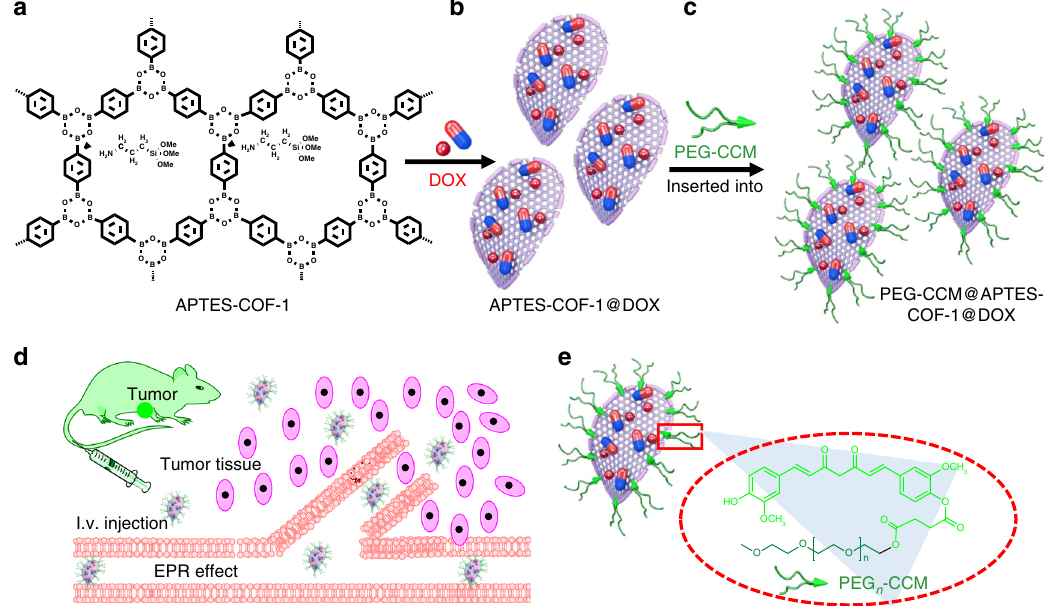
Fig. 1 Schematic representations. a – d Synthesis of DOX-loaded PEG-CCM@APTES-COF-1 with cellular uptake at weak acidic tumor tissue/cells (i.v. injection intravenous injection). e Synthesis of PEG-CCM amphiphilic block copolymers containing hydrophobic blocks based on the unplugging of the PEG- CCM polymer from the APTES-COF-1